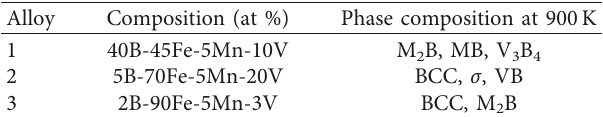
Table 2: Thermodynamic parameters for the Fe-Mn-V system from the work